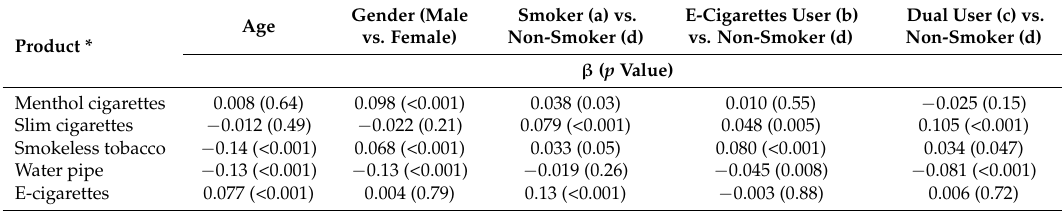
Table 3. Associations between the perceived harmfulness of tobacco/nicotine products and age, gender, smoking, and e-cigarette use #